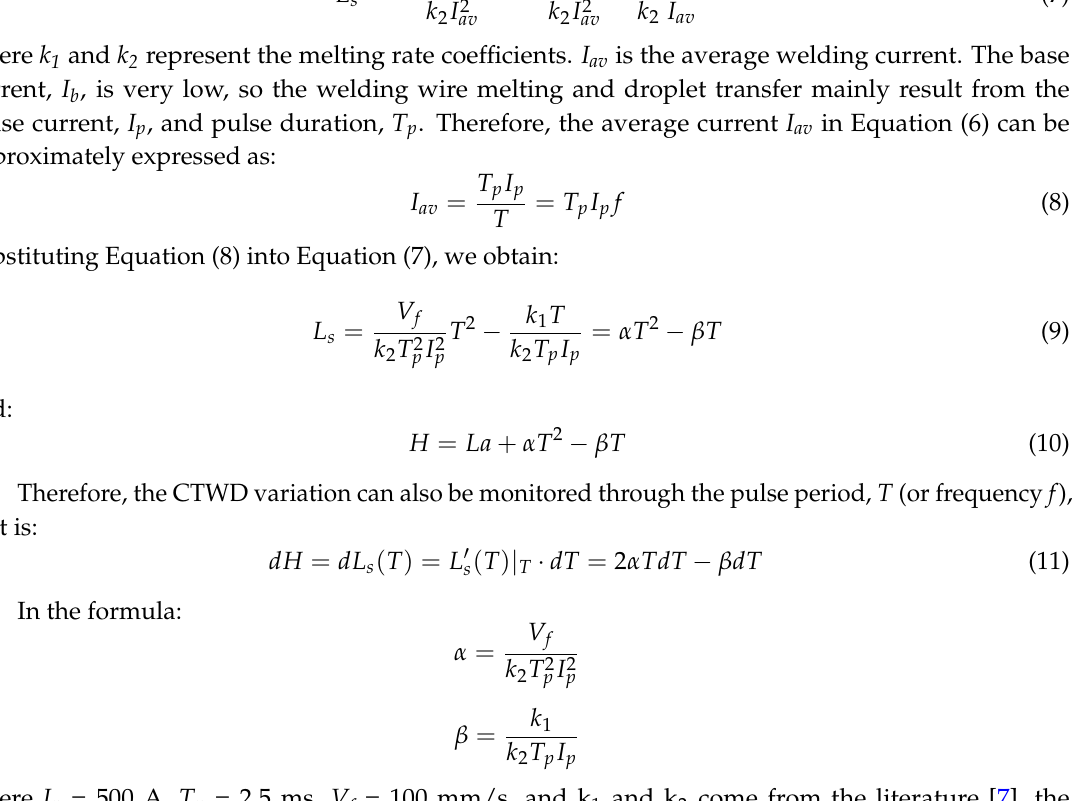
Figure 2 . Voltage signal when the CTWD decreases: ( a ) arc length and stickout variation; ( b ) voltage changing process. The superscript p represents the pulse voltage and b represents the base voltage.